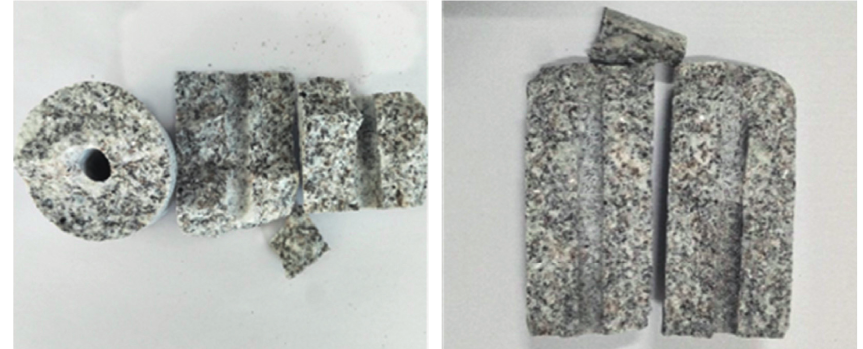
Figure 12: Fracture failure morphology of the granite specimen with a vertical hole under different impact pressures with unequal- amplitude